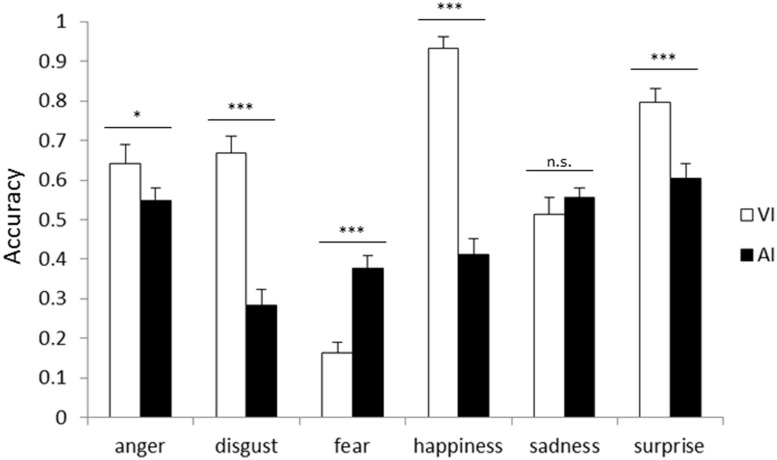
Accuracy for each emotion category in visual instruction (VI) block and auditory instruction (AI) block. Error bars represent SE. Asterisks indicate significant differences between modalities (*p < 0.05, ***p < 0.001).